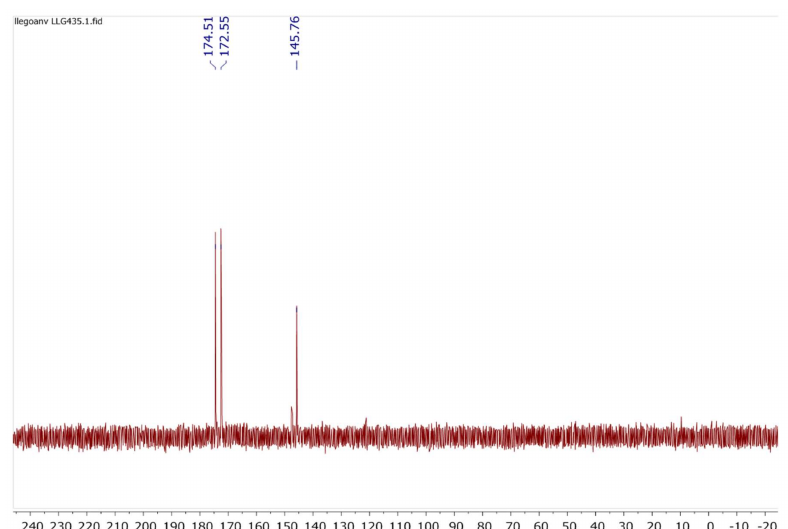
Figure A14. 31 P NMR (tol d8 , 162 MHz, 298 K) spectrum of RhH(biphephos)(CO) 2 species. The doublet at δ = 173.5 ppm stands for RhH(biphephos)(CO) 2 and the signal at δ = 146.7 ppm corresponds to free